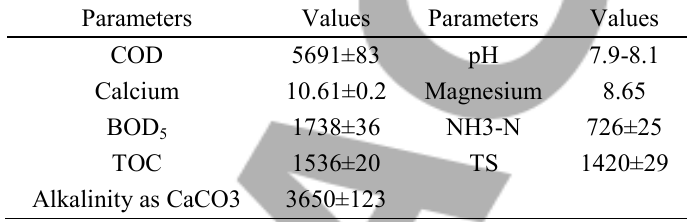
Table 1 . Chemical characteristics of the studied landfill